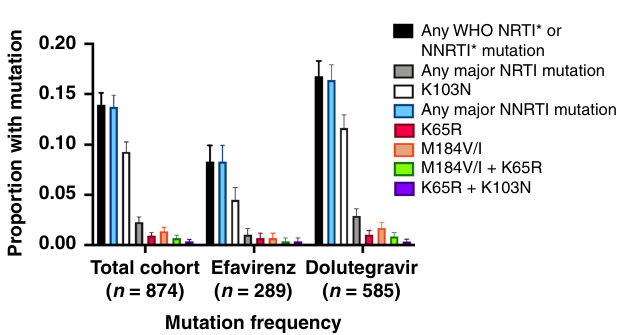
Fig. 2 Distribution of WHO-de fi ned pretreatment drug resistance in the ADVANCE trial, using the WHO Surveillance Drug Mutations list for mutations detected at >20% of the viral quasispecies. Error bars indicate 95% con fi dence intervals around the proportion